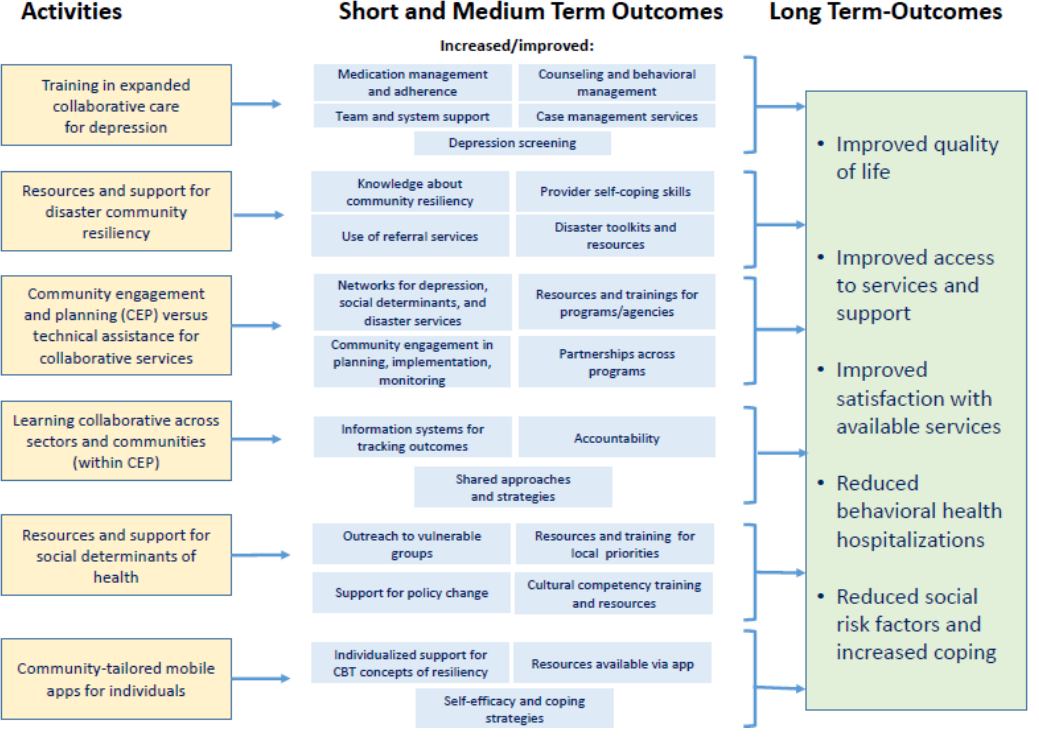
Figure 2. C-LEARN Logic Model.